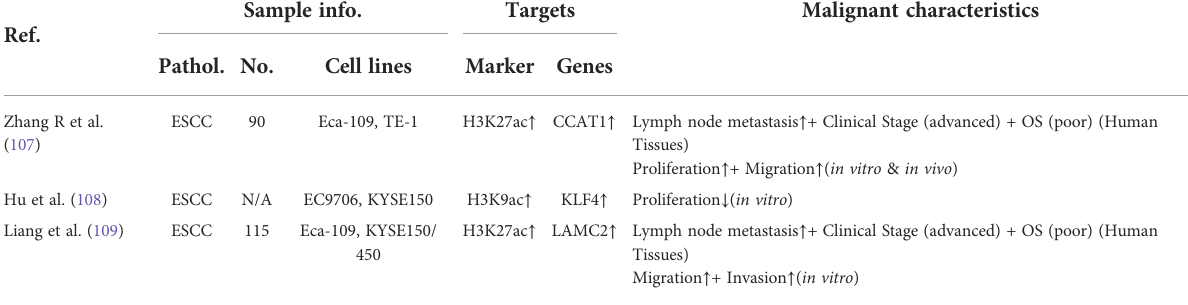
TABLE 3 The associations between dysregulated histone acetylation modi fi cations and advanced oncogenic features.